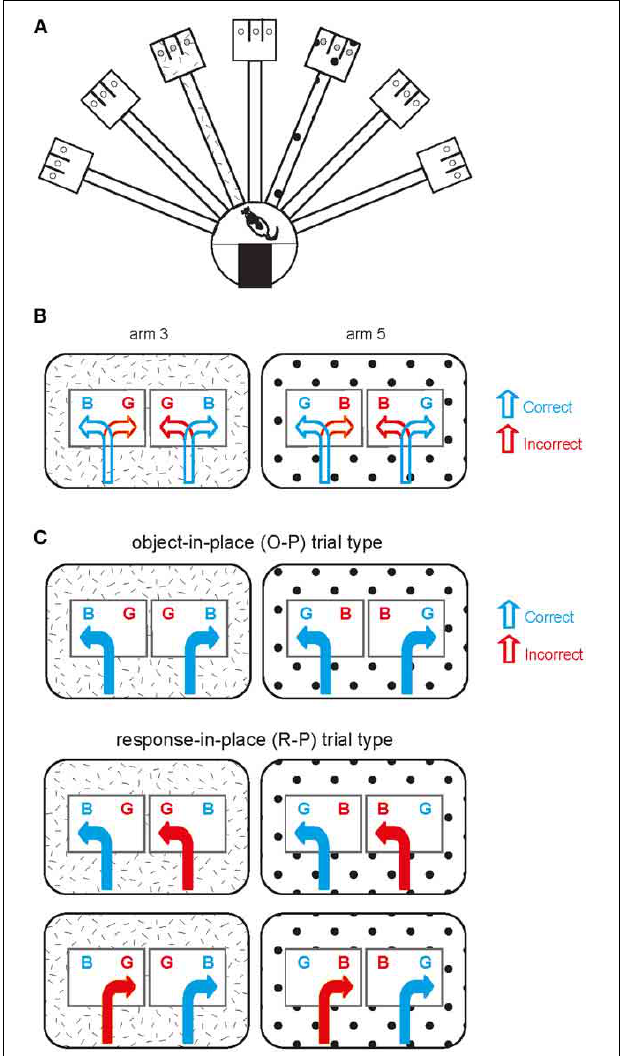
FIGURE 1 | Object-place paired association task. (A) Illustration of an overview of the radial arm maze used in the current study. The hatched pattern and polka-dot pattern in arm 3 and arm 5 are for illustration purposes only (see below) and there was no explicit local cue in the real maze. (B) Schematic illustration of the behavioral task. Two arms are represented by the patterns (distinct spatial contexts) in the outer rectangular areas. Two possible object configurations (BG and GB with B standing for obj-B and G for obj-G; B and G were rewarded in arm 3 and arm 5, respectively) are shown with two possible behavioral choices (correct and incorrect choices) per object configuration in each arm. (C) Illustration of different trial types observed within a session. Object-in-place (O-P) trial type includes the trials in which opposite response directions are associated with choosing the same target object in a given arm, whereas response-in-place (R-P) trial type involves the trials in which the same directional responses to different objects lead to a correct choice in one case but to an incorrect choice in the other case in a given arm.